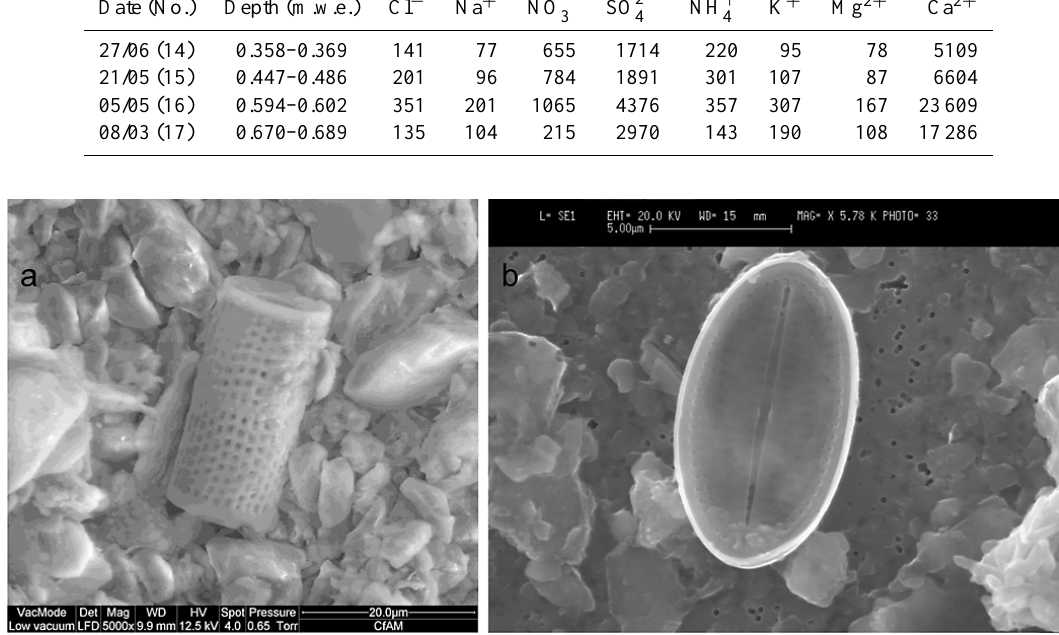
Fig. 10. Diatoms in the dust samples: (a) fresh-water Aulacoseira sp. attributed to 05 May 2009 deposition event and (b) (most likely fresh-water) Cocconeis sp. attributed to 19 May 2011 event. Classified by N. Cameron, University College London, UK.